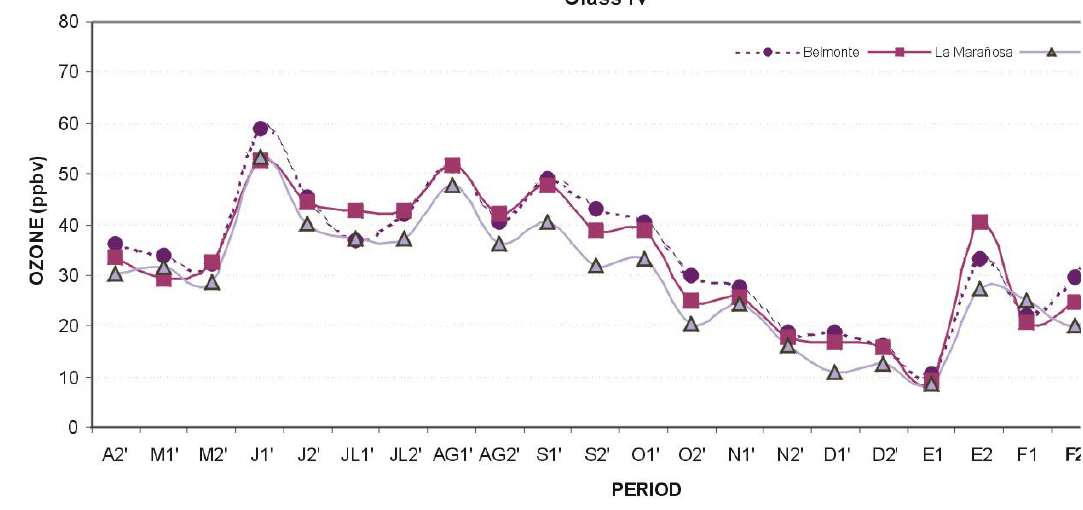
FIGURE 6. Ozone 2-week averages (ppbv) for all the Class IV locations from mid-April 2000 (April 2) to end of March 2001 (March